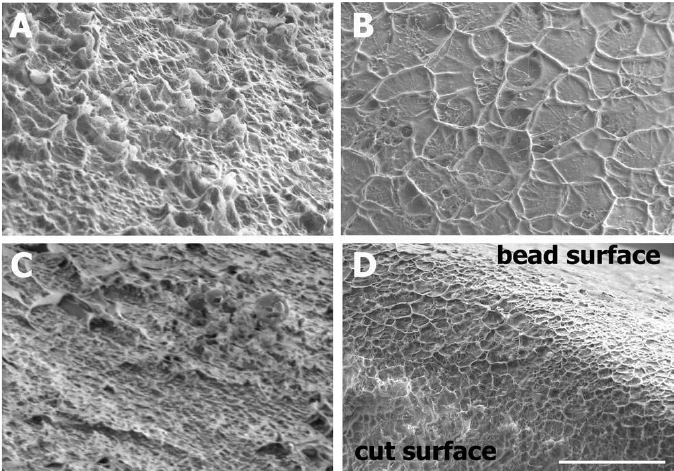
Figure 2. Cryo-SEM of alginate (Sigma A0682) beads showing external bead surfaces for ( A ) a 2% alginate extrusion bead, ( B ) a 2% alginate emulsion bead and ( C ) a 5% alginate emulsion bead, as well as ( D ), a 5% alginate bead cut in half, with the cut surface facing the camera. The scale is the same for all images. Adapted with permission from [43], Wiley Online Library, 2012.